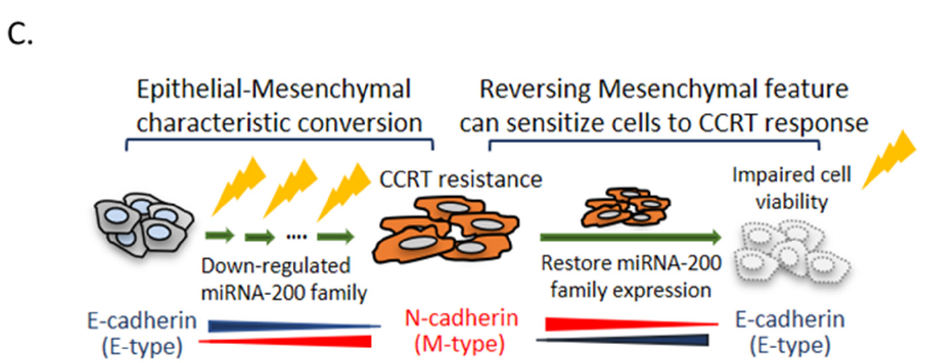
Figure 5. N-cadherin status is a potential marker to predict CCRT response in ESCC patients. ( A ) 137 endoscopic biopsy ESCC tissue samples before CCRT treatment were collected and subjected to immunohistochemistry analysis using anti-N-cadherin antibody. Representative photos showed the scoring criteria by staining intensity: 0, negative (-); 1+, positive; 2+, moderately positive; and 3+, strongly positive. Scale bar: 50 µ m. ( B ) Higher N-cadherin-expressed ESCC tissue specimens exhibited a poor response to CCRT treatment. In total, 86 of 137 tissue samples expressed higher N- cadherin, 55 of 86 tissue samples (64%) were poor response to CCRT, whereas 31 of 86 tissue samples (36%) showed good response to CCRT treatment. ** mean tissue specimen was broke. ( C ) Schematic diagram illustrating the potential mechanism of ESCC acquire CCRT resistance. During the interval of CCRT treatment, down-regulated miR-200 family modulates the conversion of epithelial to mes- enchymal feature that enables cells acquire resistance capacity to CCRT treatment. Rescue miR-200 family expression can convert CCRT resistance cells to epithelial feature and modulate the sensitivity to CCRT